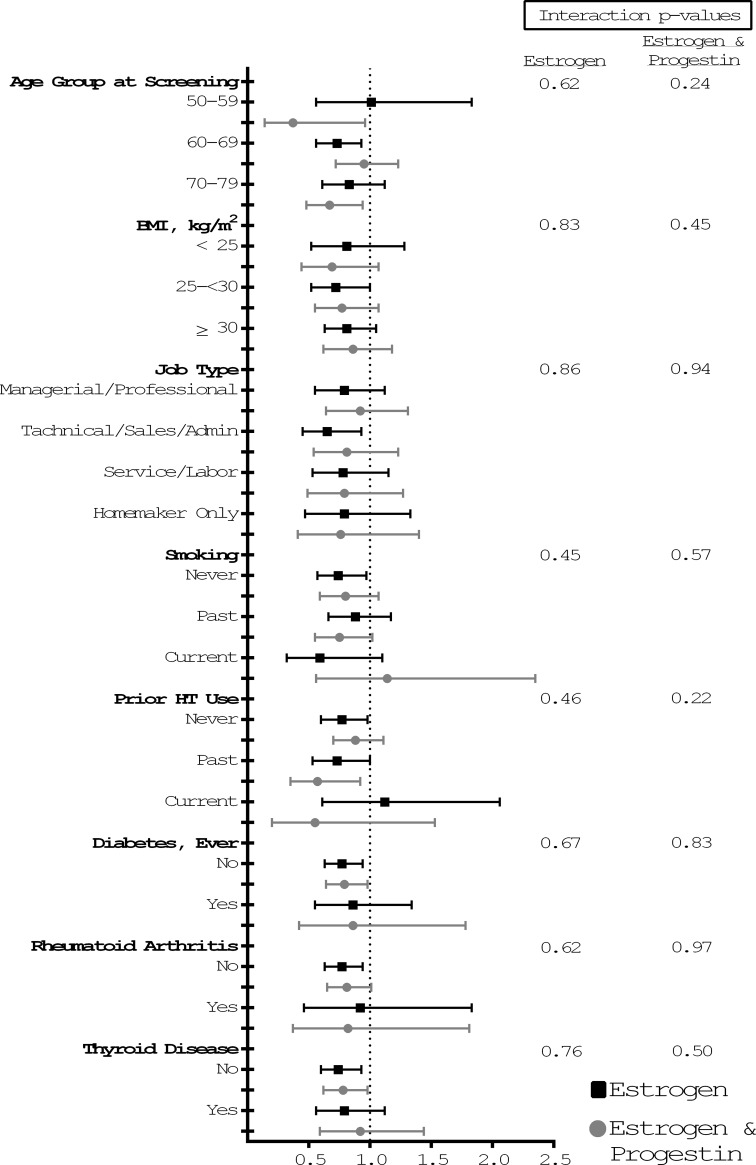
Subgroup analysis for development of carpal tunnel syndrome diagnosis by demographic and medical history.Subgroup analysis for development of CTS. Point estimates represent hazard ratios of the intervention compared to placebo and the whiskers are 95% confidence limits. BMI, Body Mass Index. There was no statistically significant interaction. The P values shown have not been adjusted for multiple comparisons.